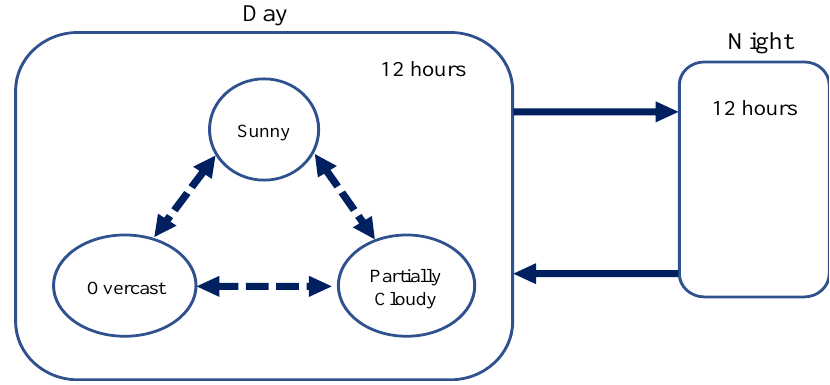
Figure 4. Switching schematic between different cloud coverage states and night. (dashed arrows denote stochastic switching and solid arrows denote deterministic switching).